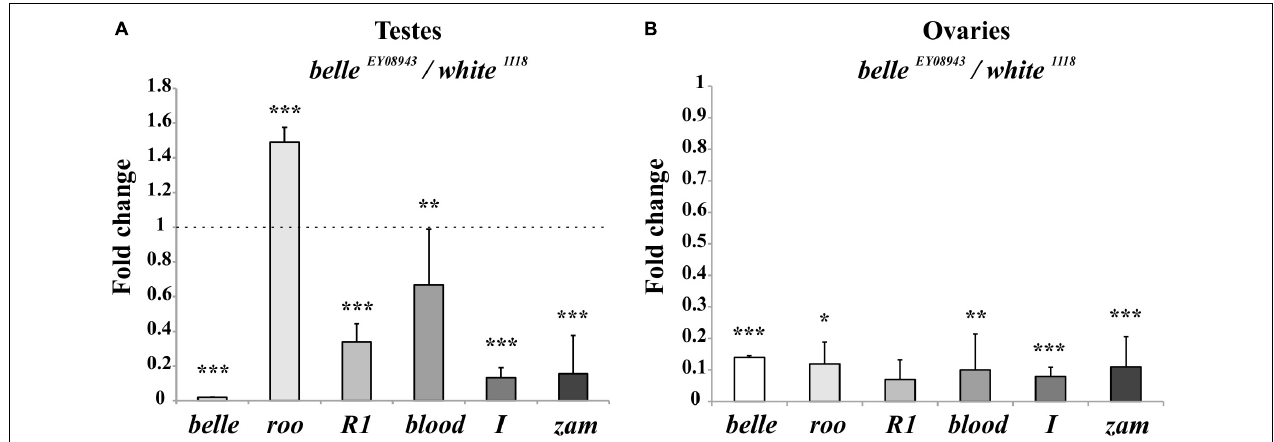
FIGURE 9 | Altered TEs expression in belle mutant gonads. qRT-PCR on ovaries (A) and testes (B) from belle EY 08943 and white 1118 flies reared in 12:12 LD cycles and collected at ZT3. Represented relative mRNA levels of belle and five TEs ( roo, R1 , blood , I-element, and ZAM ) in belle EY 08943 compared to white 1118 , control, to which an arbitrary value of 1 was assigned. Represented are mean ± SD of three biological replicates. ∗∗∗ p < 0.005, ∗∗ p < 0.01, ∗ p <